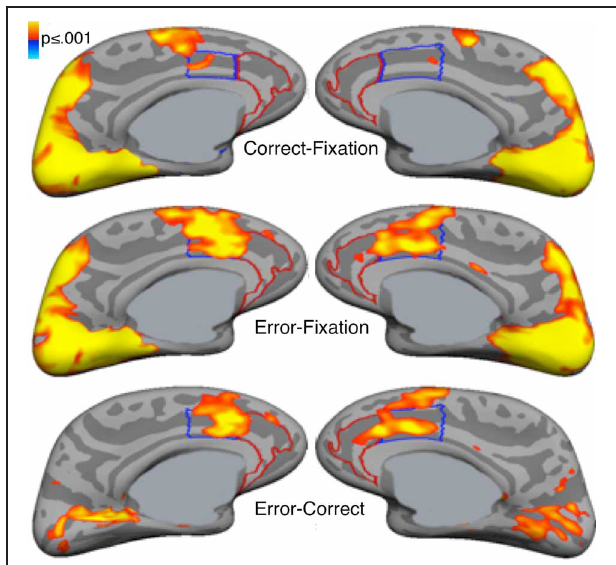
FIGURE 3 | Error-related activation in the anterior cingulate cortex (ACC). Statistical maps, displayed on medial cortical surface templates, show activation on correct trials vs. a fixation baseline (top), error vs. fixation (middle) and error vs. correct (bottom). Gray masks cover subcortical regions in which activation is displaced in a surface rendering. The dACC and rACC are outlined in blue and red, respectively. Adapted from Polli et al.